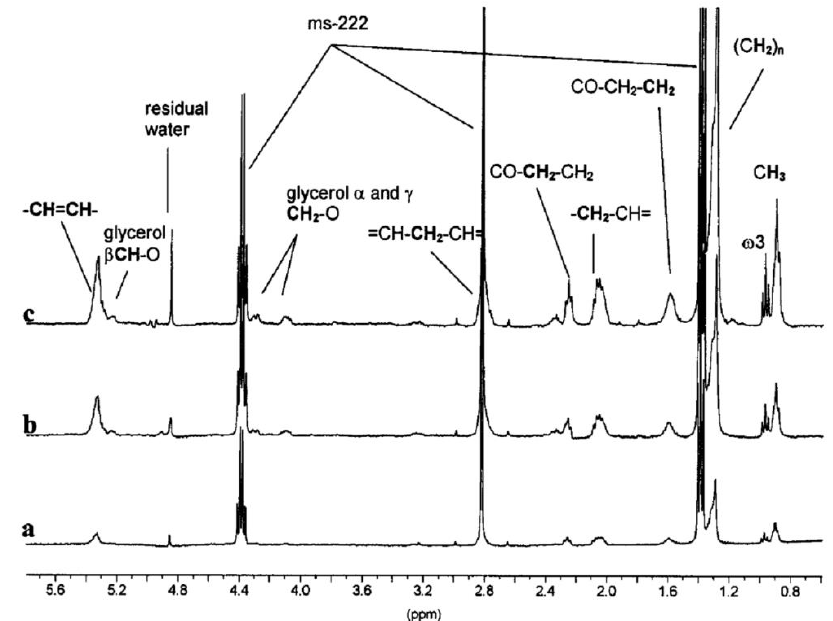
Figure 3. Example assigned spectra obtained from in-vivo proton high resolution-magic angle spinning (HR-MAS) NMR experiments examining Daphnia magna at: ( a ) 24 h old, ( b ) 7 days old with and ( c ) 7 days old without eggs in the brood pouch [129]. Reproduced with permission from Royal Society of Chemistry.